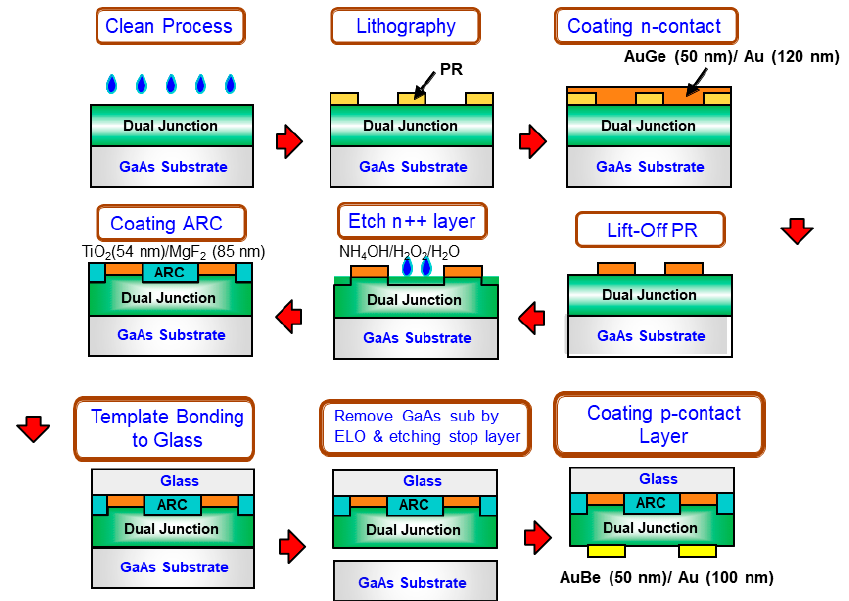
Figure 1. Processing flowchart of the DJ solar cells.